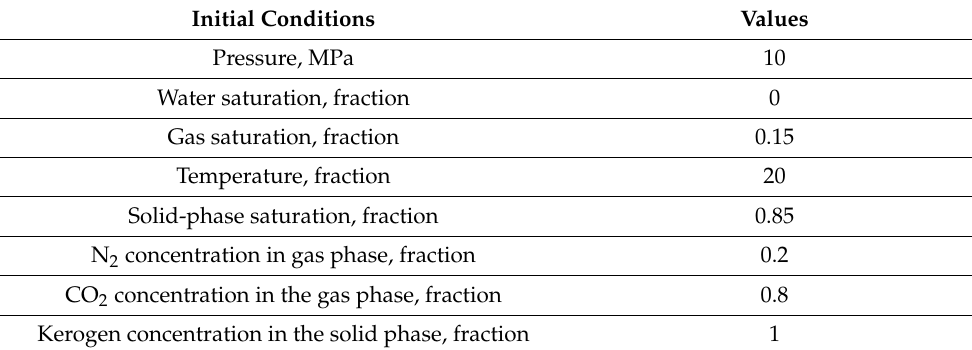
Table 3. Initial conditions.